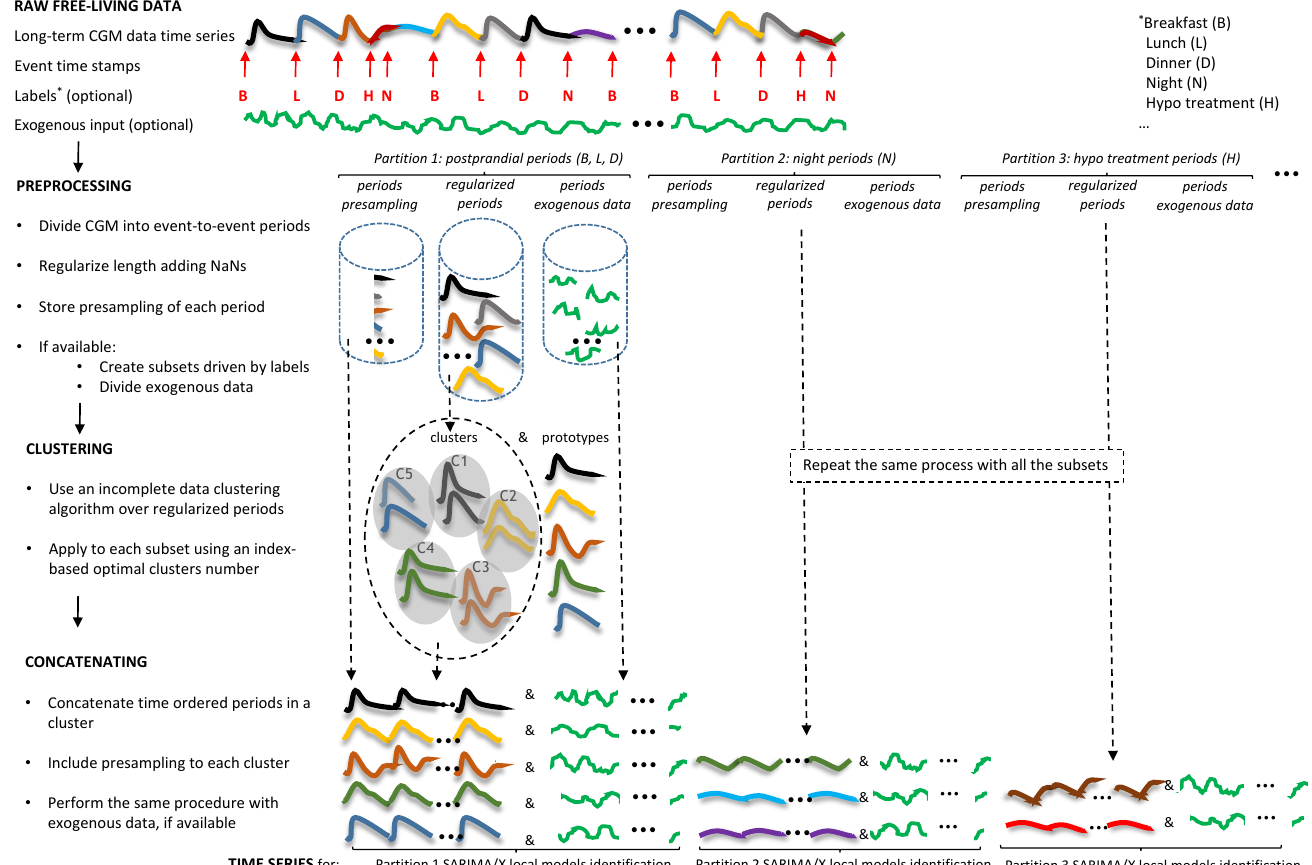
Figure 2. Data processing steps during the training phase. Optional event labels may include: Breakfast (B), Lunch (L), Dinner (D), Night (N), Hypo treatment (H),